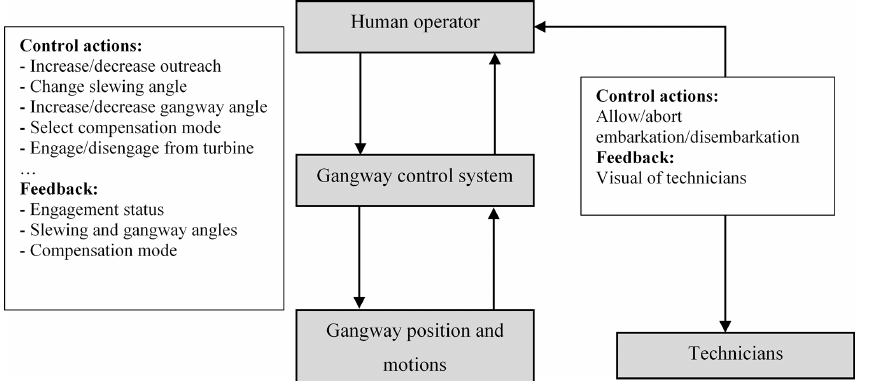
Figure 5. Gangway control diagram with sample control and feedback